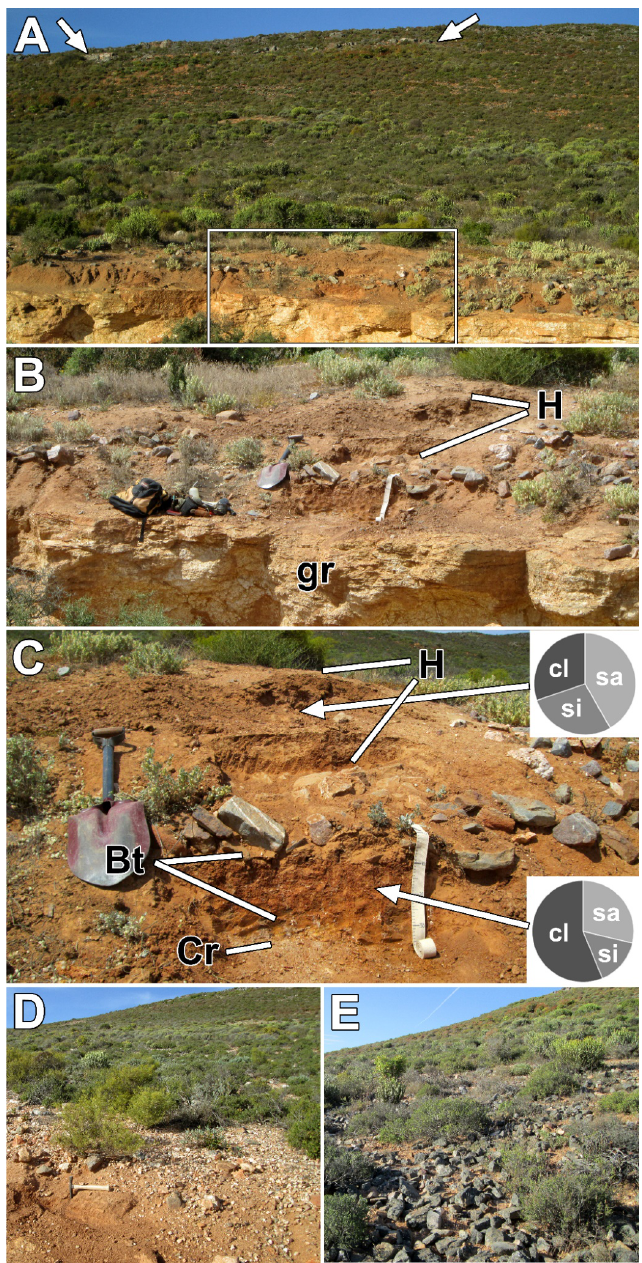
Figure 12. ( A ) Upslope view across the borrow pit location north of Nuwerus. The white arrows at the top of the view indicate outcroppings of quartzite. The white rectangle in the lower centre is shown in enlarged view below in ( B ); ( B ) View of the borrow pit exposure showing the continuous line of quartzite cobbles, beneath which is the reddened Bt soil horizon (centre of view) and weathered granite (gr). The downslope edge of a heuweltjie (H) is exposed in the section and contains lighter-coloured, silt- and fine sand-rich soil materials; ( C ) Close-up view of the well-developed, reddened Btk horizon beneath the quartzite cobbles. The Cr horizon consists of weathered granite with little clay accumulation. Light-coloured soil materials of the heuweltjie are emplaced on the top of the layer of quartzite cobbles. Note the continuity of the layer in the exposed section of the heuweltjie in the centre. Pie diagrams show the percentages of sand (sa), silt (si), and clay (cl) as measured with the hydrometer method; ( D ) The margin of borrow pit exposure to the immediate north of the view in ( C ) showing the surface layer of quartzite colluvium, with the reddened Bt horizon beneath it (lower left corner beneath hammer); ( E ) Backslope location showing the surface clad in a continuous mantle of angular colluvial cobbles, derived from outcrops further